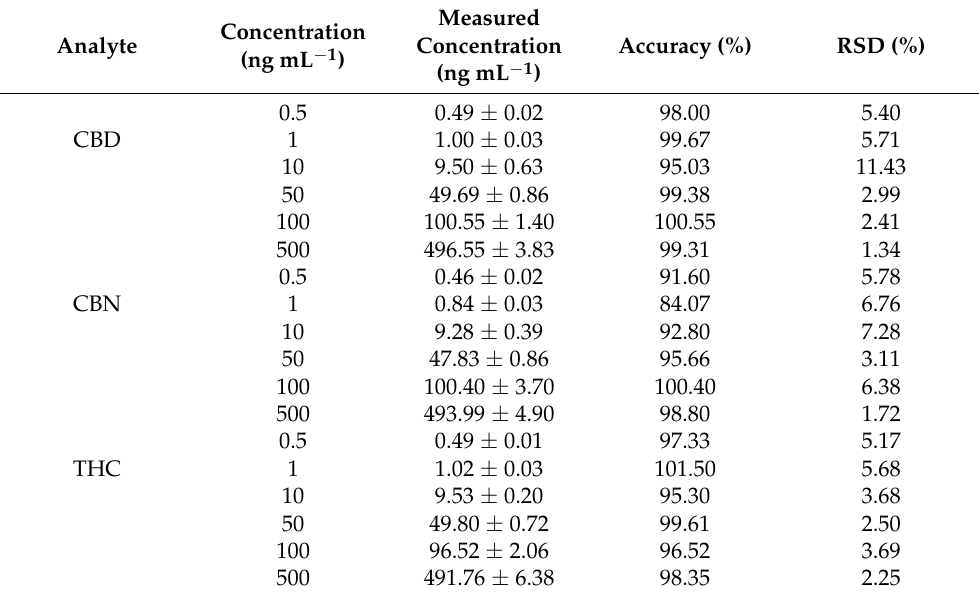
Table 5. Precision and accuracy of the determination of cannabinoids in Moringa oleifera powder ( n = 3, mean ± SD).